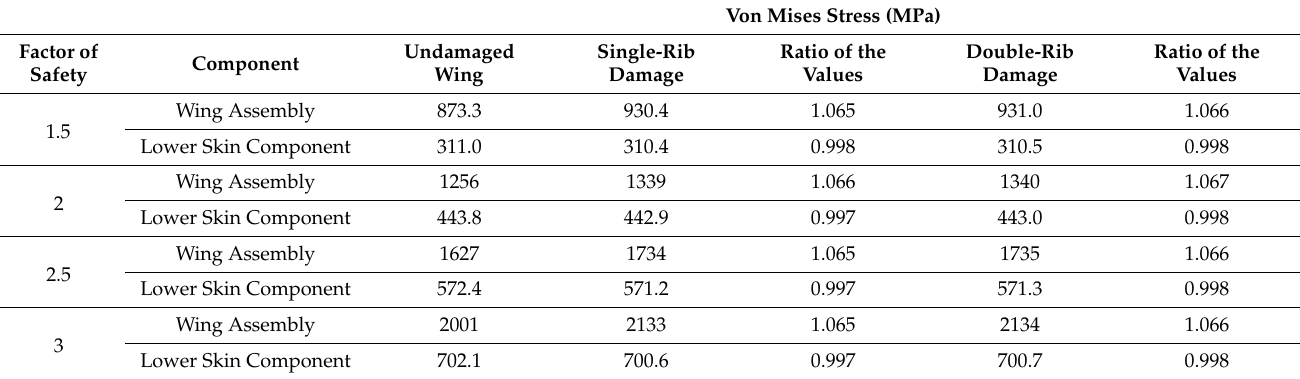
Table 19. Comparison of von Mises stress in the undamaged wing and wing containing rib damage.